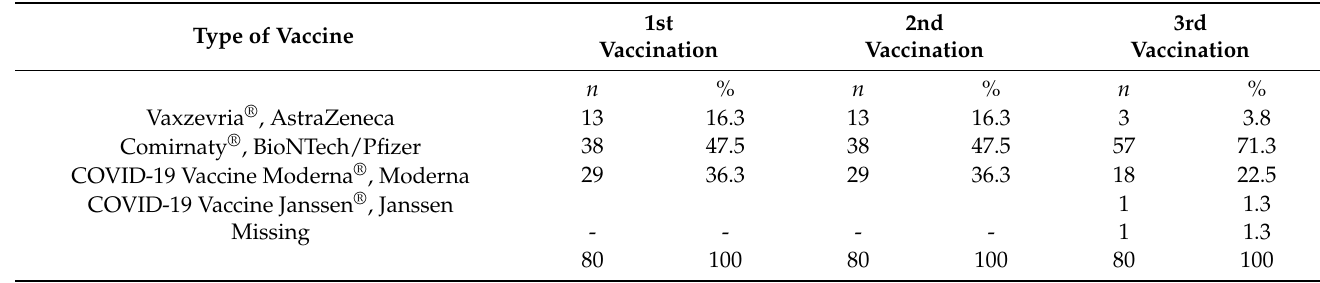
Table 1. Frequencies and percentages of patients by vaccination received (1st, 2nd and 3rd). Type of